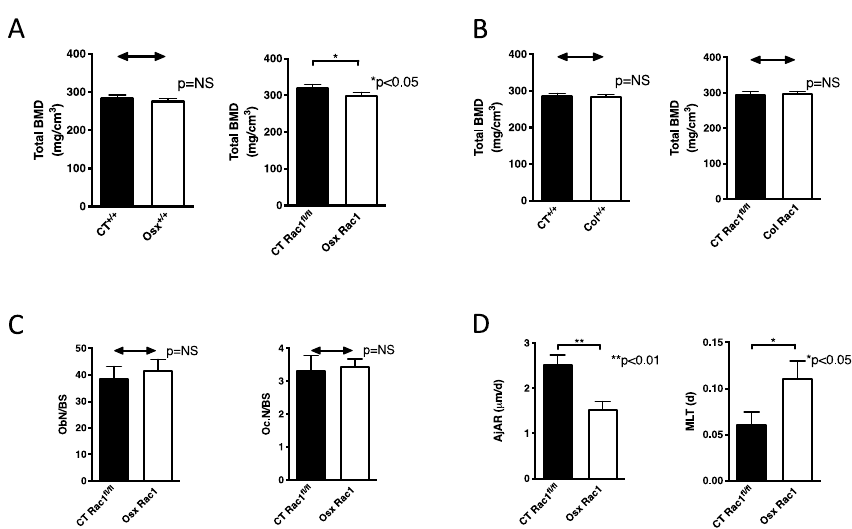
Figure 3. Bone mineral density and osteoblast differentiation are decreased in the absence of Rac1 in preosteoblasts. ( A ) Bone mineral density (BMD) in the presence of osterix-Cre in wildtype mice (Osx +/+ ) was not affected compared to wildtype littermate control mice (CT +/+ ), but deletion of Rac1 using osterix to drive Cre expression (Osx Rac1) diminished bone mineral density compared to littermate controls with the genotype Rac1 fl/fl (CT Rac1 fl/fl ). n = 27/37 and 20/19. ( B ) Bone mineral density in the presence of collagen α 1(I)-Cre in wildtype mice (col +/+ ) was not affected compared to wildtype littermate control mice (CT +/+ ). Similarly, the deletion of Rac1 using collagen α 1(I) to drive Cre expression (Col Rac1) did not affect bone mineral density compared to littermate controls with the genotype Rac1 fl/fl (CT Rac1 fl/fl ). n = 18/18 and 18/23. ( C ) Deletion of Rac1 using Osx-Cre did not affect the number of osteoblasts (Ob.N) or osteoclasts (Oc.N) when adjusted to bone surface (BS). Data were obtained using static histomorphometry of tibia sections after excluding the primary spongiosa for a width of 150 μ m. The bone was evaluated along the longitudinal axis for a total length of 1.5 mm starting from the exclusion line distally. n = 10/5. ( D ) Osteoblast function was diminished in Osx Rac1 mice compared to littermate controls. The adjusted apposition rate (AjAR) reflects the function of a group of osteoblasts, which is diminished, while mineralization lag time (MLT) represents the time needed for the osteoblasts to mineralize the matrix. The function is diminished if MLT is prolonged. n = 10/5. All studies were performed without doxycycline treatment and repression of Cre recombinase expression. Bone mineral density was measured in 3 weeks old mice. The values were compared between every two groups in all subpanels using t- tests.